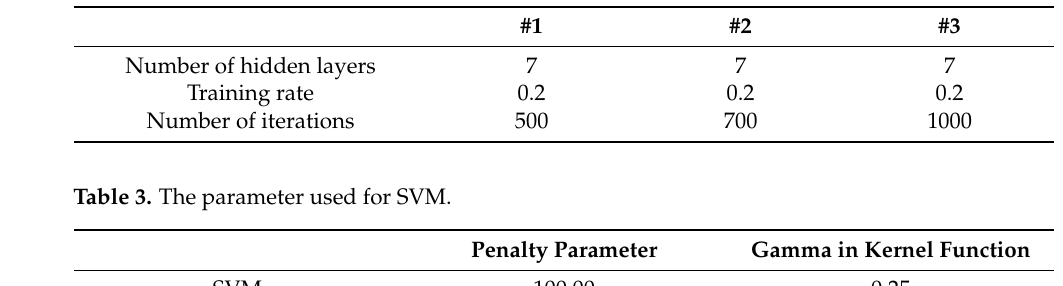
Table 2. The combinations of parameters for the artificial neural network.